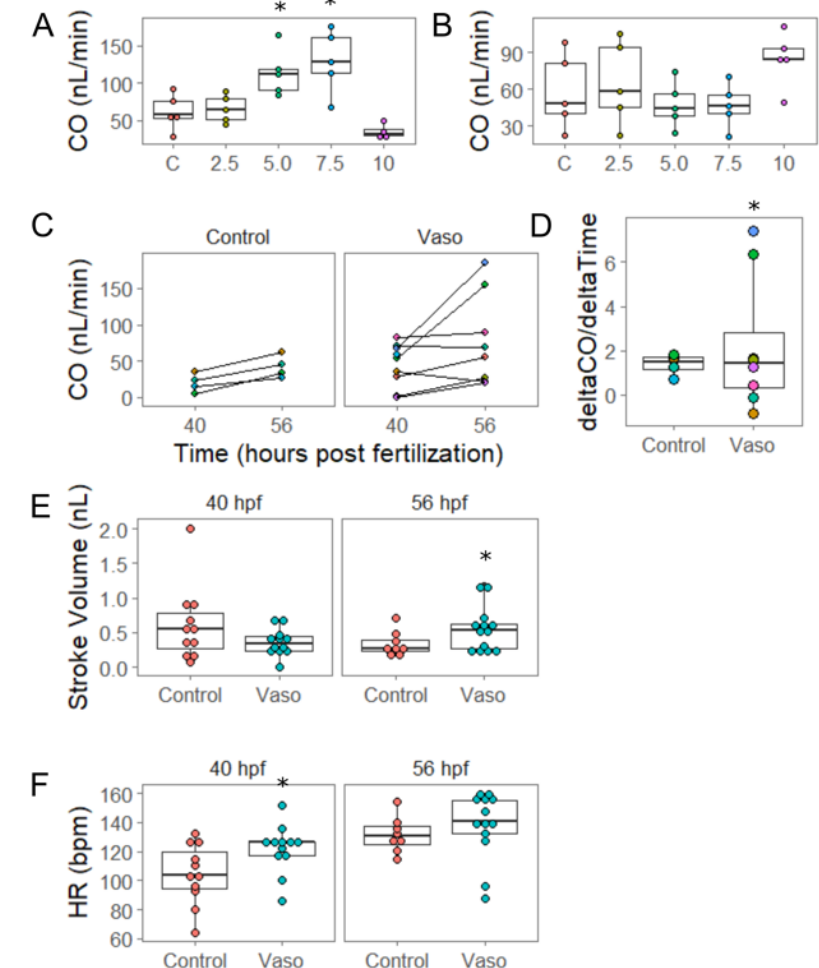
Figure 2. Increased pressure causes chamber remodeling by 56 hpf. ( A ) Cardiac output (CO) at 40 hpf at increasing doses of vasopressin (control, 2.5, 5, 7.5, and 10 µ m). ( B ) CO at 56 hpf at increasing doses of vasopressin (vaso). n = 5 fish per group. ( C ) Cardiac output at 40 and 56 hpf in control and 10 µ m vaso-treated fish. Each colored dot represents an individual fish; orange-colored dots represent control fish, light blue represents mildly-affected fish, and purple represents severely-affected fish. n= 4 control, 8 vaso. ( D ) Rate of change for cardiac output with respect to time. ( E ) Stroke volume and ( F ) heart rate of control and 10 µ m vaso-treated fish at 40 and 56 hpf. n = 11 control and 12 vaso-treated fish at 40 hpf, and 8 and 13 vasopressin-treated fish at 56 hpf. * indicates p < 0.05. The embryos that were exposed to the 10 µ M dose reacted differently than those exposed to lower doses. First, they did not achieve an increase in cardiac output by 40 hpf, but instead demonstrated a significant decrease in cardiac output (Figure 2C; control = 50.6 nL/min, vasopressin = 32.26 nL/min, p = 0.04 by t -test, n = 15